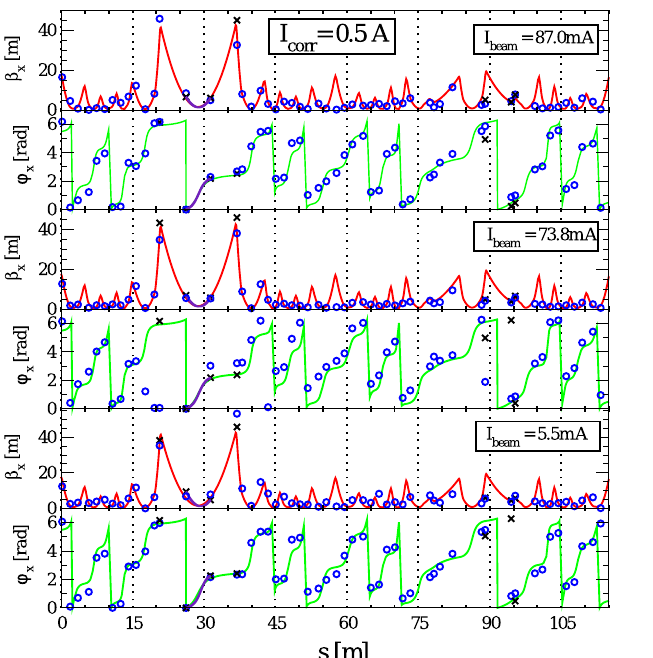
FIG. 5. Same measurement as in Figs. 3 and 4 for I beam ¼ ¼ 2 A 78 : 8 mA and I corr